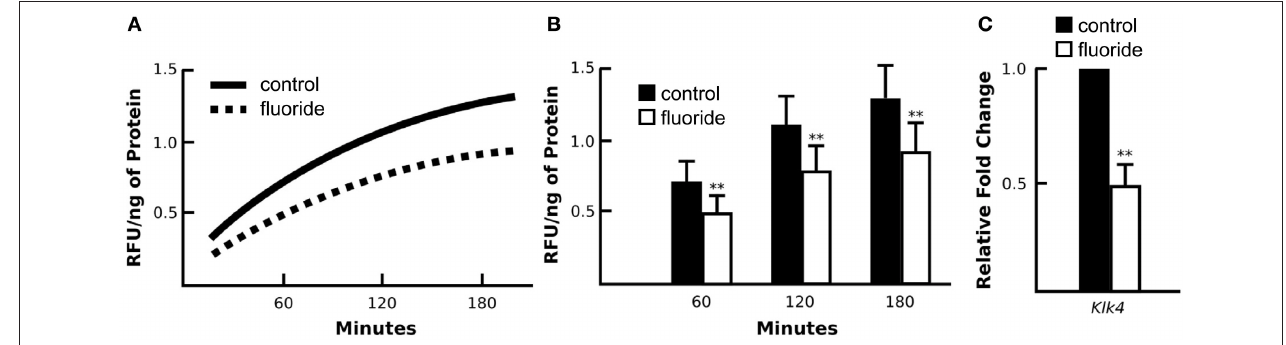
FIGURE 1 | Enamel fluorosis associates with reduced in vivo KLK4 activity and Klk4 expression. (A) Averaged profile model of KLK4 activity in early maturation enamel matrix protein extracts (line graph). (B) At three time points of measurement (60, 120, and 180min after the start of incubation), fluorosed enamel showed significantly lower KLK4 activity (bar graph). ** p < 0.01. (C ) Relative fold change of Klk4 expression from maturation-stage enamel organs harvested from control and fluorosed rats shows reduced Klk4 expression in fluoride exposed ameloblasts. Fold change was calculated relative to the baseline expression of the gene in control mice. Genes were normalized to the expression of Mrpl19 (mouse ribosomal protein L19). ** p < 0.01.